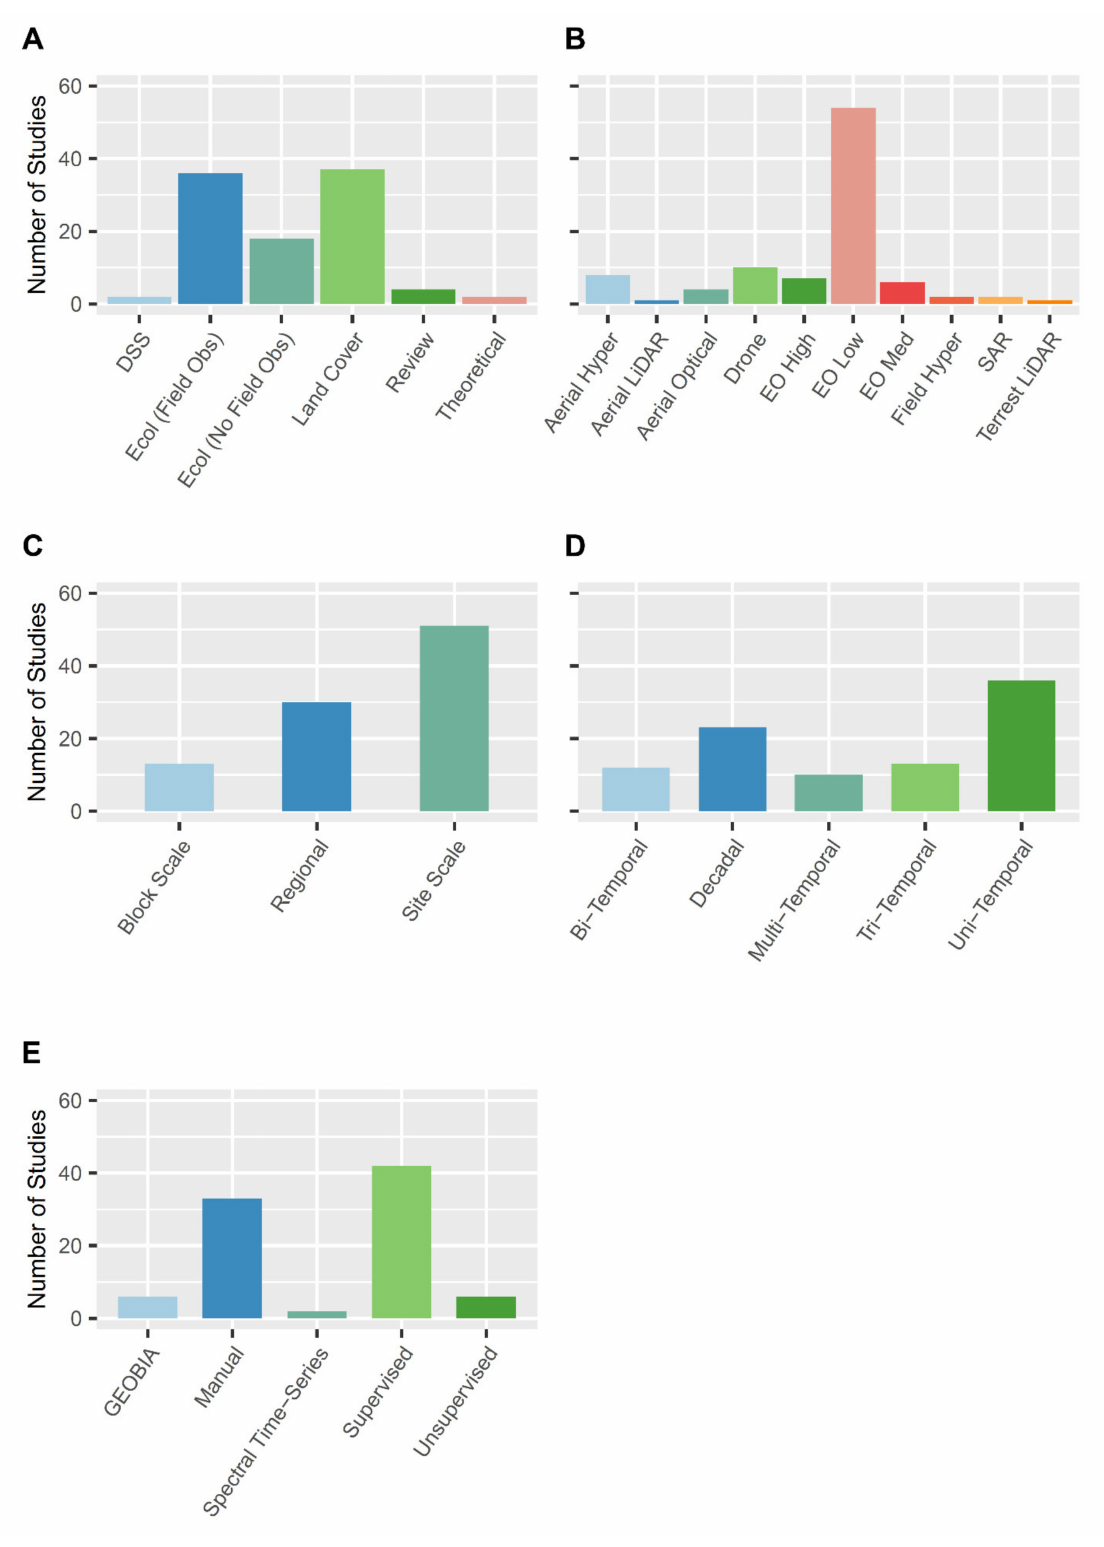
Figure 2. Summary statistics for the 99 publications reviewed showing the type of study ( A ), type of sensor ( B ), spatial extent of study ( C ), temporal scale ( D ), and classification methods employed ( E